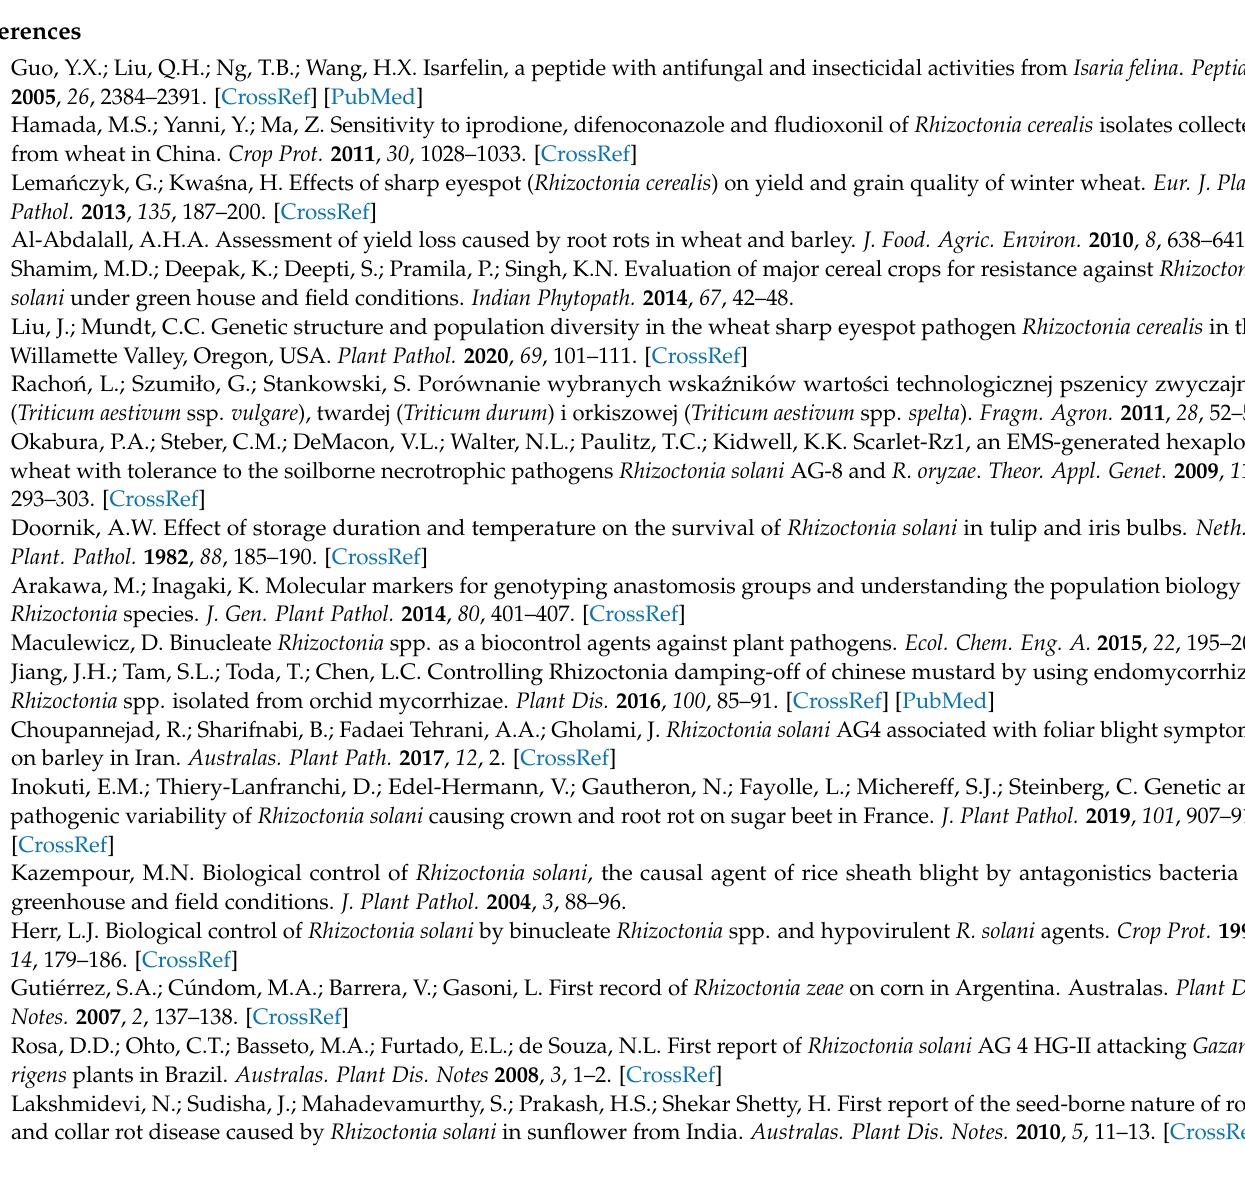
Table S1: Winter wheat genotype names used in the